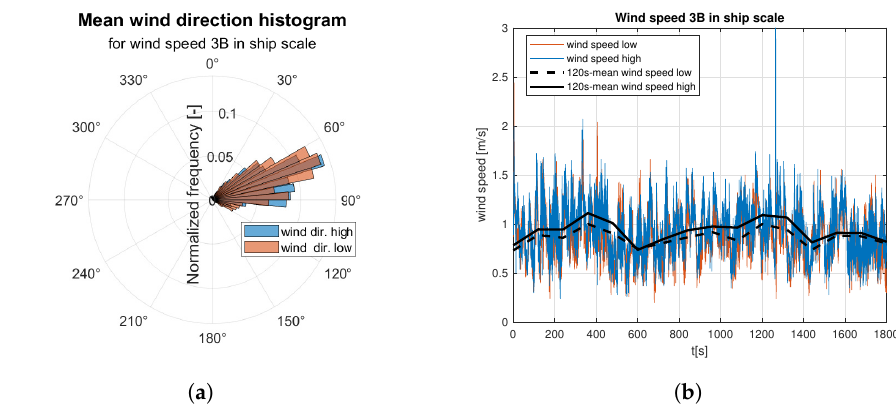
Figure 8. Raw measurements for weak wind—3BFT in ship scale: ( a ) wind rose; ( b ) time series.